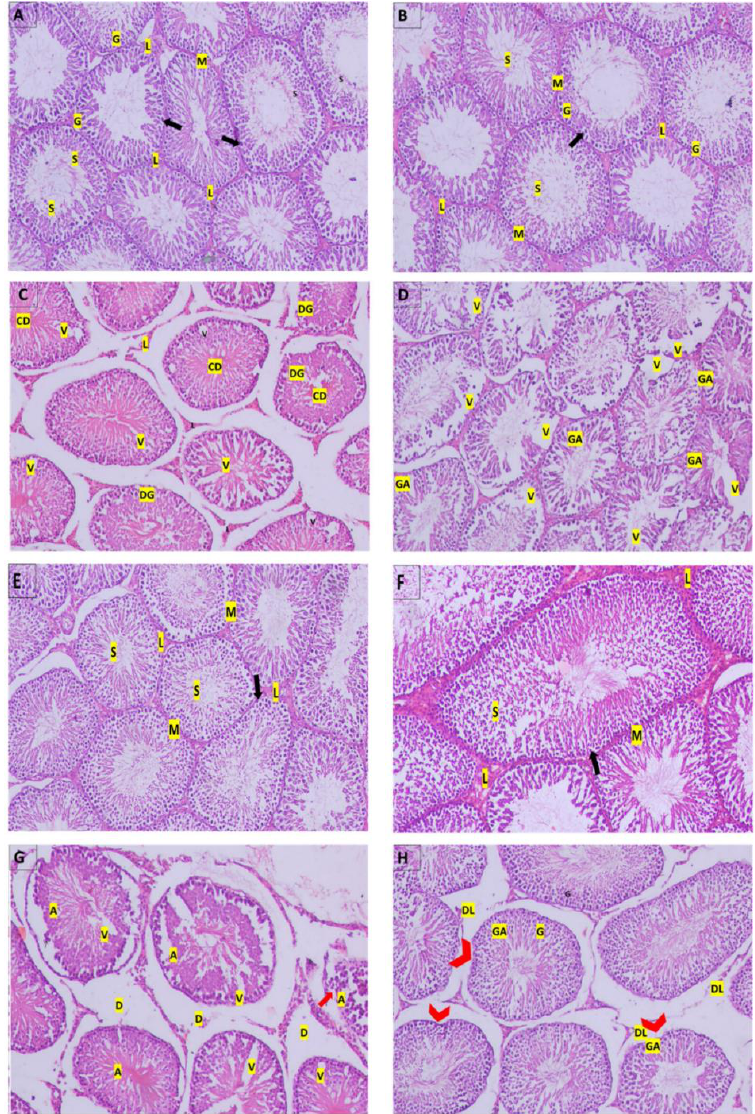
Figure 3. Photomicrographs of histological sections of rats’ testicular tissue by hematoxylin- and eosin. ( A ): Control group after 2 weeks; ( B ): RFX group after 2 weeks; ( E ): Control group after 4 weeks; ( F ): RFX group after 4 weeks; all show normal histological structure of rats’ testes with closely packed seminiferous tubules with Sertoli cells (arrow), spermatogenic cells (G), sperm (S), and were surrounded by clusters of peritubular myoid cells (M) and Leydig cells (L). ( C ): M/2 w group shows loosely packed necrotic seminiferous tubules with degenerated spermatogenic cells (DG), sperm (S), and cellular debris in the lumen, surrounded by expanded interstitial space that contained peritubular-degenerated Leydig cells (L). ( D ): M + RFX/2 w group had densely packed seminiferous tubules showing spermatogenic arrest (GA), predominantly at the level of spermatogonium, while others are vacant displayed disorganized spermatogenic cells (DG), few sperm (S), and were surrounded by peritubular myoid cells (M). ( G ): M/4 w group shows atrophied seminiferous tubules (A) with vaculation (V), the disruption of the interstitial connective tissue (D), and the detachments of the spermatogonia from the basement membrane (arrows). ( H ): M + RFX/4 w group shows partial recovery, as some of the seminiferous tubules are intact, revealing normal spermatogenic cells (G) with no vaculation and sperm (S) being abundant in the lumen; however, a few had irregular membranes (arrowhead) and showed spermatogenic arrest (GA). Leydig cells were mostly intact (L), but few were degenerated (DL). In addition, damage in the interstitial connective tissue was relatively